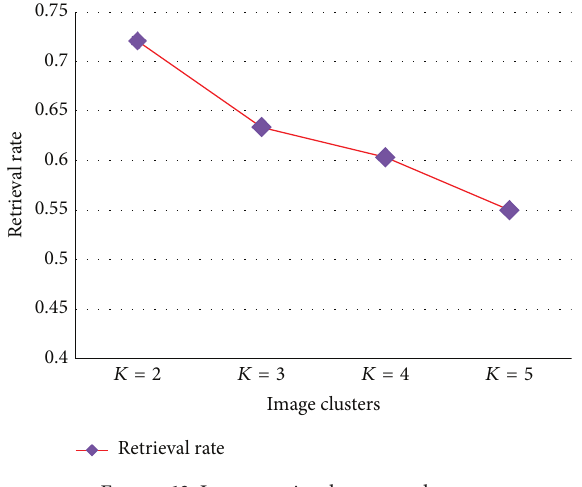
Figure 13: Image retrieval rate per